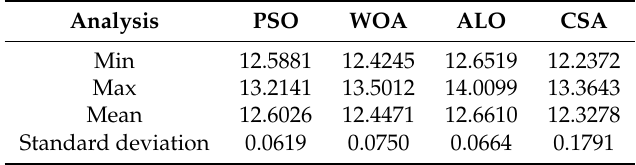
Table 6. Results of real power loss P loss (MW) for IEEE 14-bus